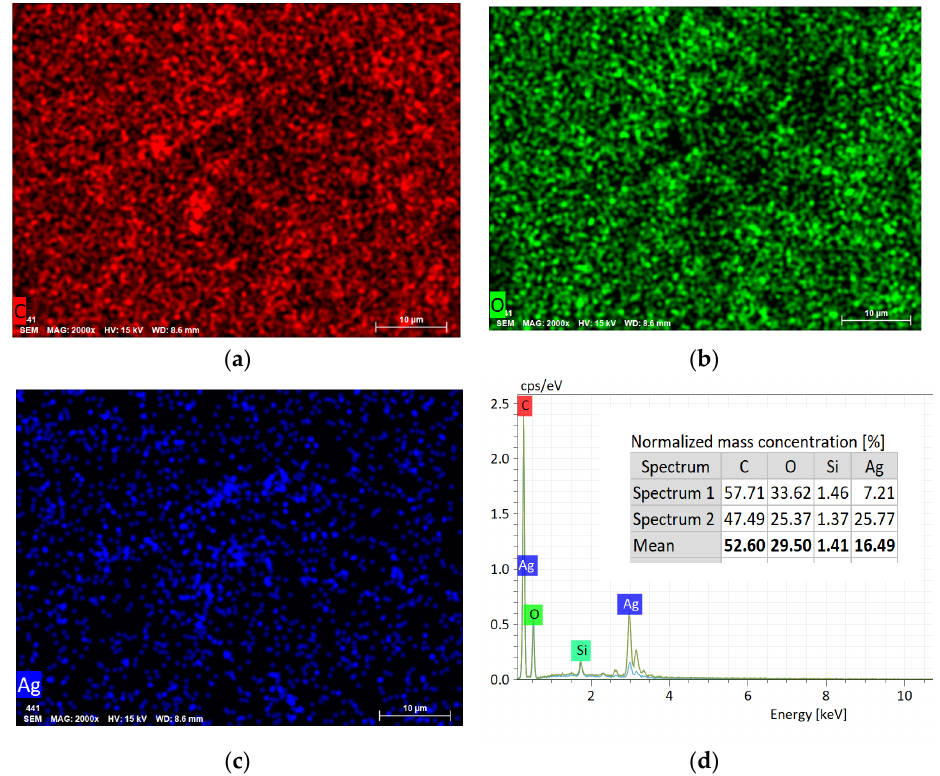
Figure 3. The elemental distribution of C ( a ), O ( b ), Ag ( c ) and energy dispersive X-ray spectrum ( d ) of the BCP-Ag nanocomposite.